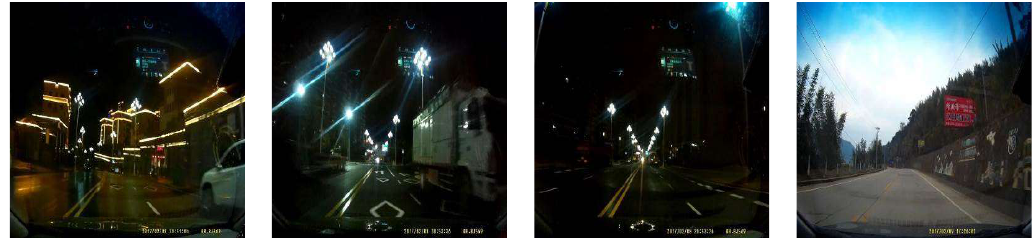
Figure 16. Other typical road environments.